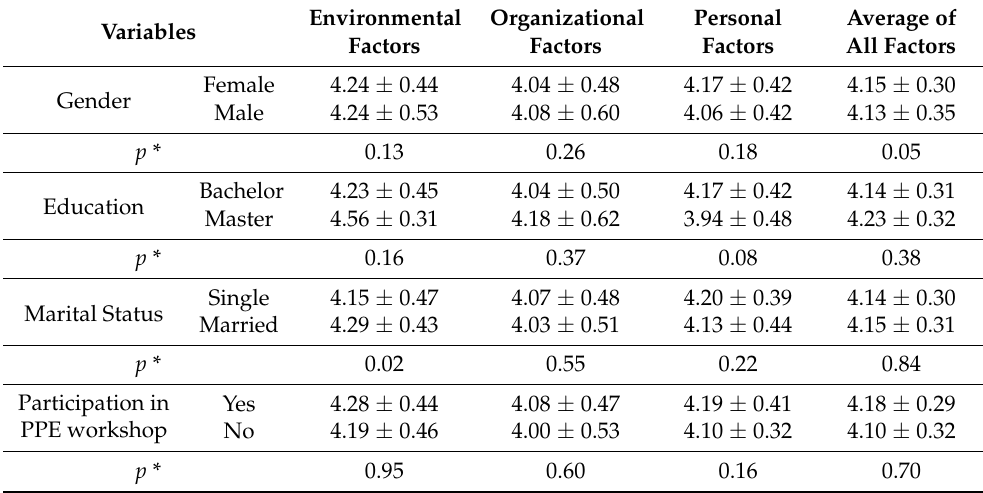
Table 3. Comparison of the mean scores of the factors affecting nurses’ compliance with using PPE based on gender, marital status, education, and previous participation in a PPE workshop. Variables